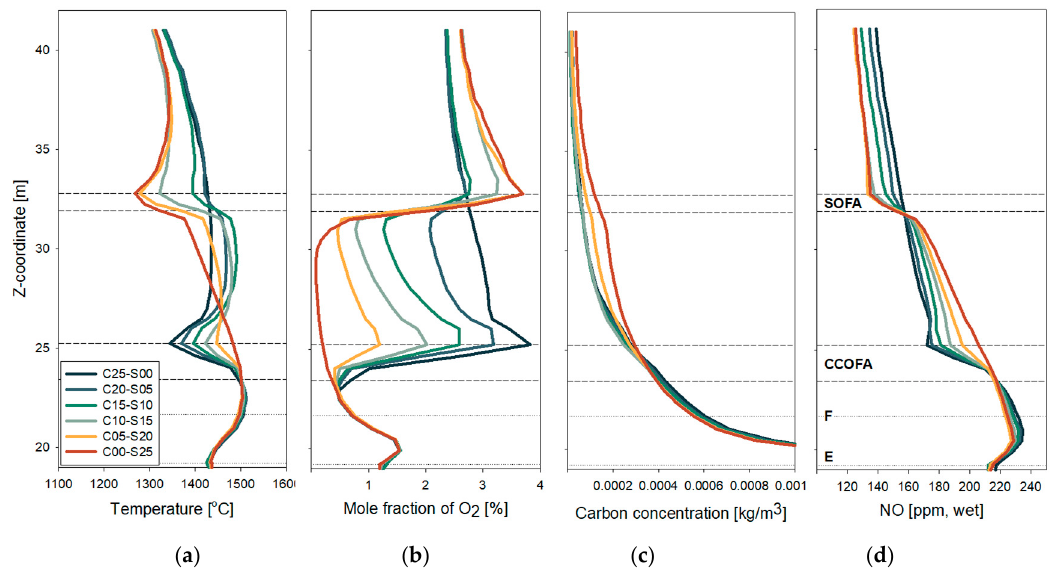
Figure 10. Mass-weighted average profiles of gas temperature and concentrations of O 2 , solid carbon, and NO between E burner level and primary superheater for different CCOFA/SOFA distribution (total OFA ratio fixed at 25%). ( a ) Temperature; ( b ) O 2 ; ( c ) Solid carbon and ( d ) NO.